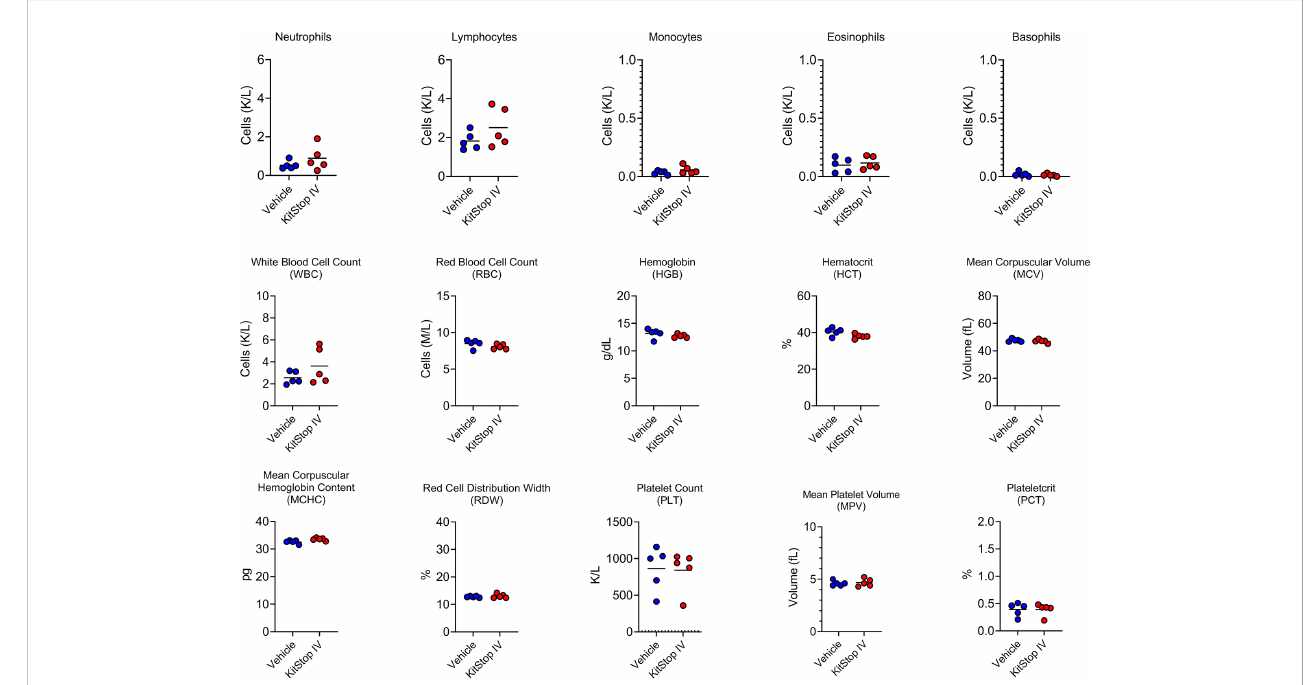
FIGURE 5 Intravenous KitStop treatment does not result in hematopoietic abnormalities. Complete blood count parameters measured from whole blood isolated from Balb/c mice with cardiac puncture after 21 days of either PBS vehicle control (blue) or KitStop ESO (red) treatment administered every 3 days. No signi fi cant differences were observed between the